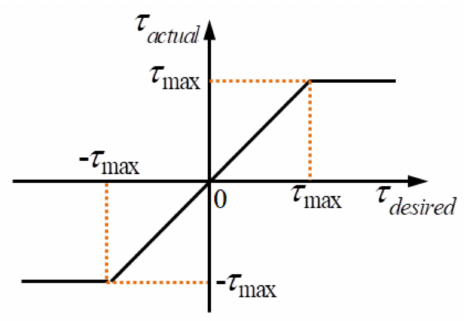
Figure 4. Desired input and actual output of control